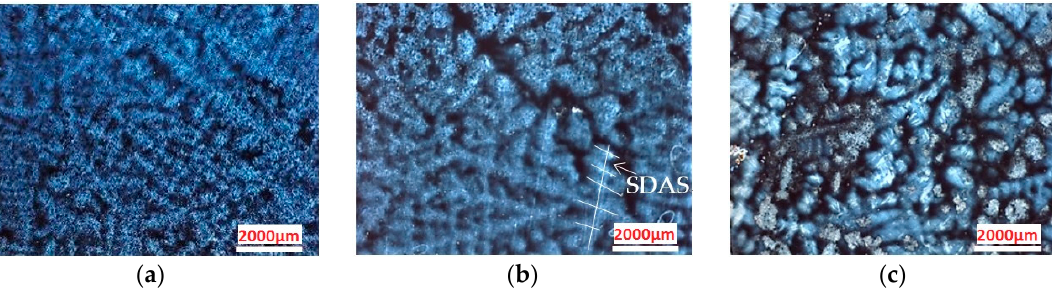
Figure 3. Micrographs of the three studied regions on the axial face along the section of 30 cm below the hot-top/casting body separation interface: ( a ) Region 1 in the periphery ( d 2 = 366 μ m); ( b ) region 2 in the ½ radius position ( d 2 = 474 μ m); ( c ) region 3 in the center ( d 2 = 536 μ m).